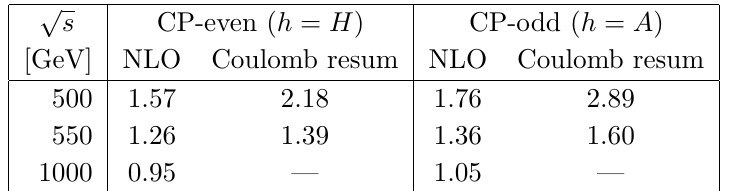
Table 1 . K -factors by NLO and Coulomb-resummation corrections to the total cross sections of the process e + e (cid:0) ht (cid:22) t for the CP-even ( h = H ) and CP-odd ( h = A ) cases, at p s =500 GeV, ! 550 GeV, and 1000 GeV.